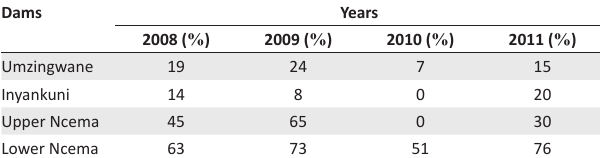
Source : Photograph taken by S. Phiri FIGURE 6: Umzingwane Dam, central